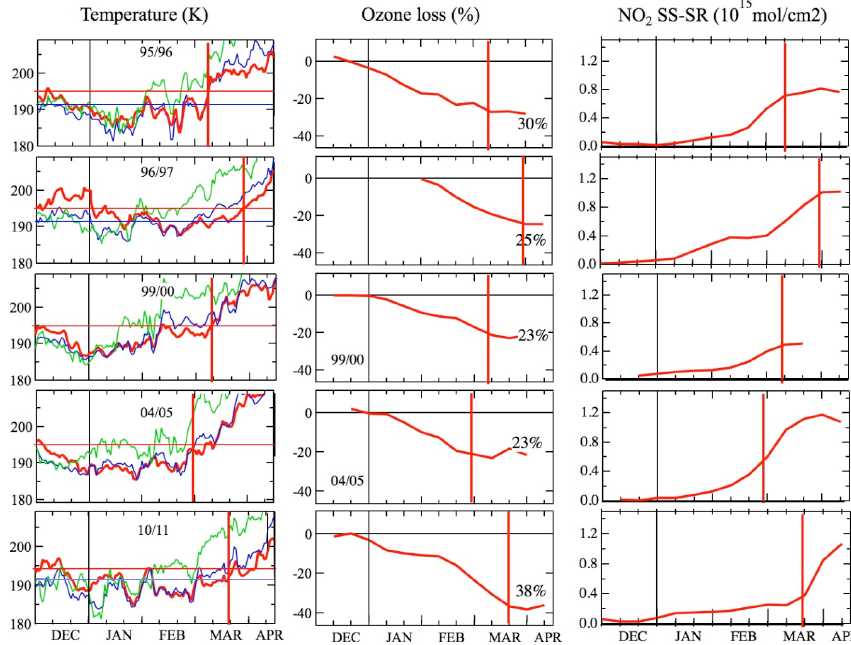
Fig. 8. Temperature, ozone loss and NO 2 diurnal variation during years of most important loss in the Arctic since 1994. Left: ERA-Interim minimum temperature north of 60 ◦ N at 475K (red), 550K (blue) and 675K (green) and respective T NAT . Middle: SAOZ ozone loss. From top to bottom: 1995-96, 1996-97, 1999-00, 2004-05 and 2010-11. Right: SAOZ NO 2 diurnal cycle amplitude. Shown by the vertical red bars are the dates of final warming.